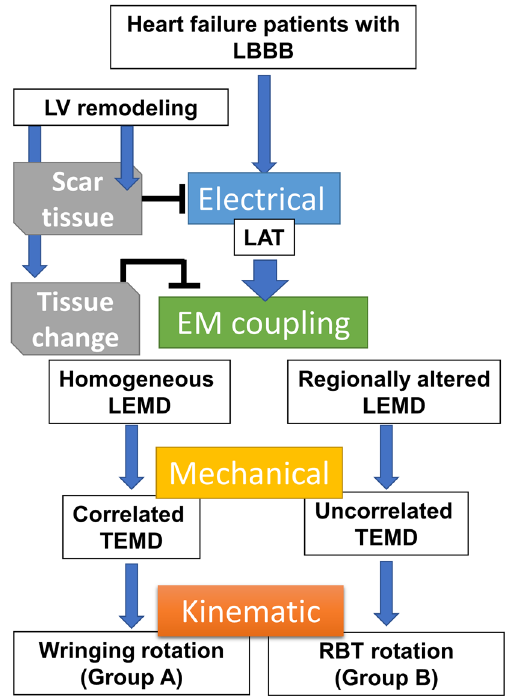
Figure 7. Scheme of the working hypothesis on the origin of differential left ventricle rotational patterns in heart failure patients mapped with an endovascular electromechanical catheter system (NOGA XP). EM electro- mechanical, LAT local activation time, LBBB left bundle branch block, LEMD local electro-mechanical delay, TEMD total electro-mechanical delay, RBT